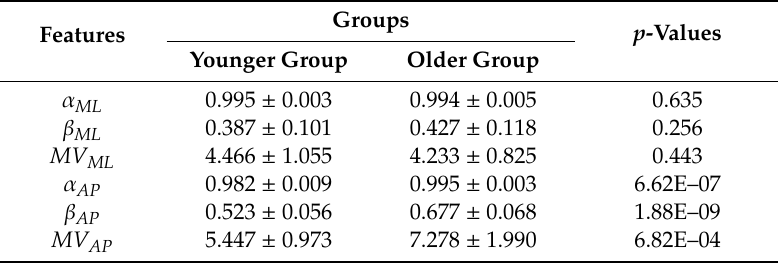
Table 1. Statistical results for the tested